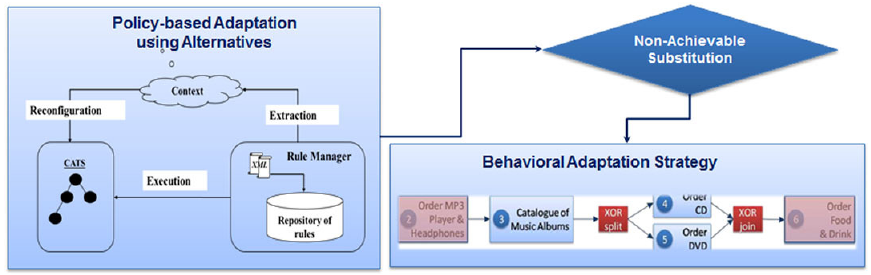
Fig. 5. Illustration of CATS adaptation